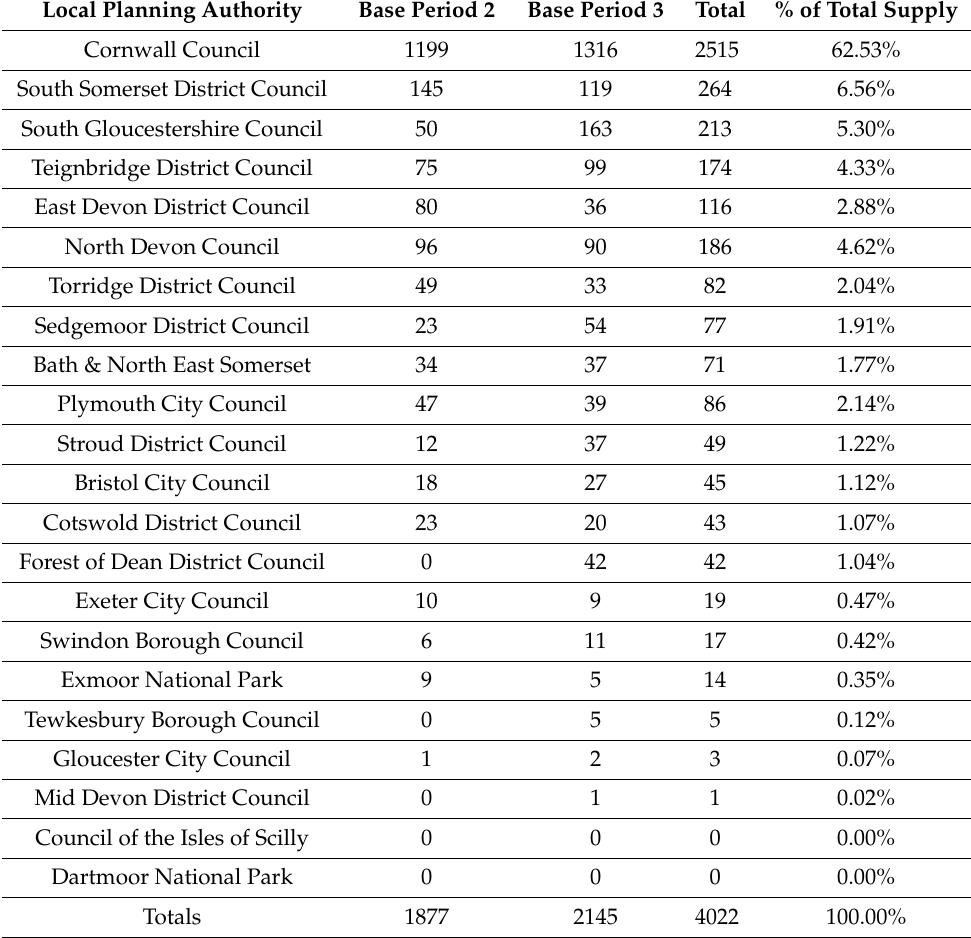
Table 10. Suitable permission granted in base periods 2 to 3 in the study